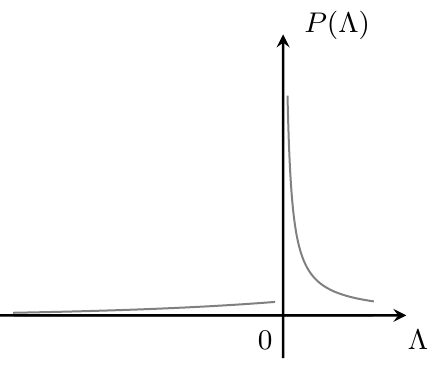
Figure 2 . Sketch (not to scale) of the properly normalized probability distribution P (Λ) for the cosmological constant Λ as expected from the model, where P (Λ) is power-divergent as Λ → 0 + . This implies that an exponentially small positive Λ is statistically preferred in the patch of string theory landscape described by the